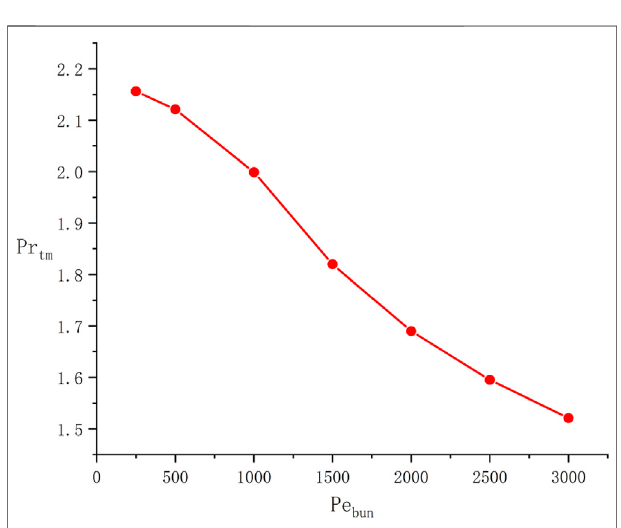
FIGURE 10 | Mean turbulent Prandtl number of the bare 19-rod